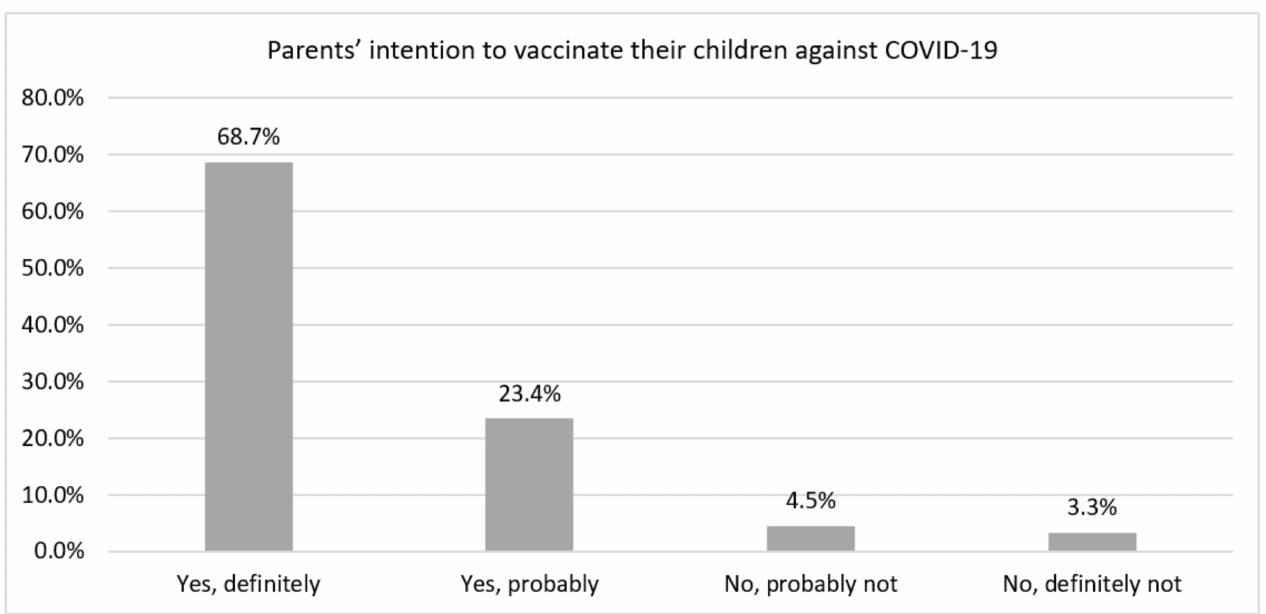
Figure 2. Frequency of parents’ answers about intention to vaccinate their children against COVID-19 in Latin America and the Caribbean countries.